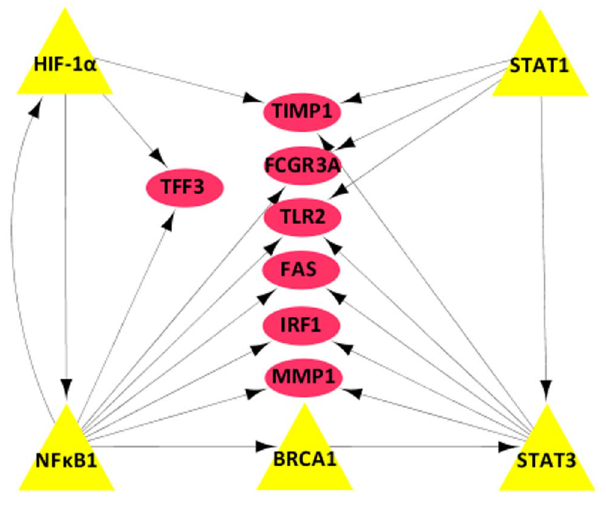
Figure 4. The hub genes are regulated by at least two TFs in this TF-gene regulatory network. Ellipses are hub genes that are regulated by transcription factors, the triangles are these five transcription factors in the TF-gene regulatory